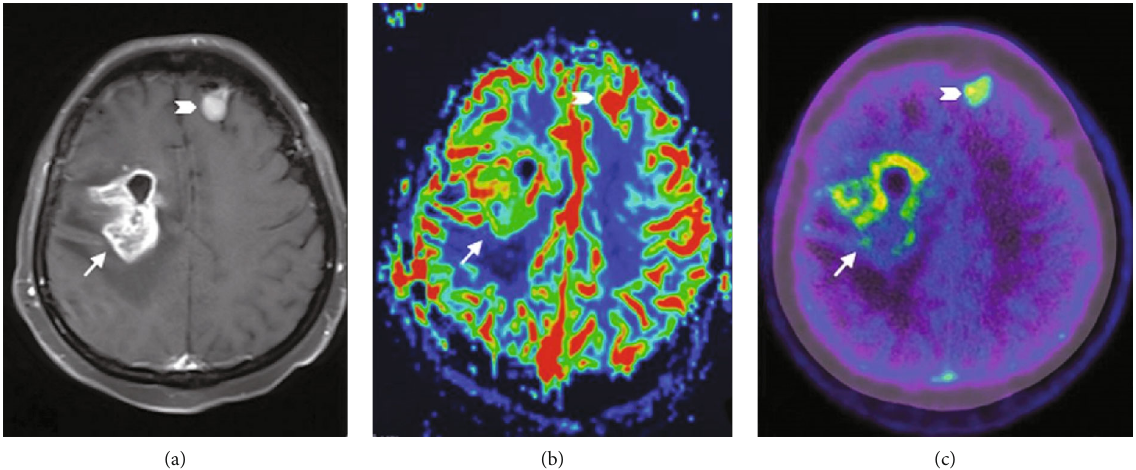
Figure 5: MET PET combined with PWI in recurrent glioblastoma. Contrast-enhanced T1-weighted MR image (a) and a relative cerebral blood volume (CBV) map (b) and a MET PET/CT image (c) for a 41-year-old woman with recurrent glioblastoma. The lesion in the right frontal lobe (arrow) shows enhancement (a) and positive fi ndings on both the rCBV map (b) and MET PET/CT image (c). The lesion localized in the left frontal lobe (chevron) might be a meningioma, which has been stable for several years. Reproduced with permission from Figure 2 of Qiao et al. [58].